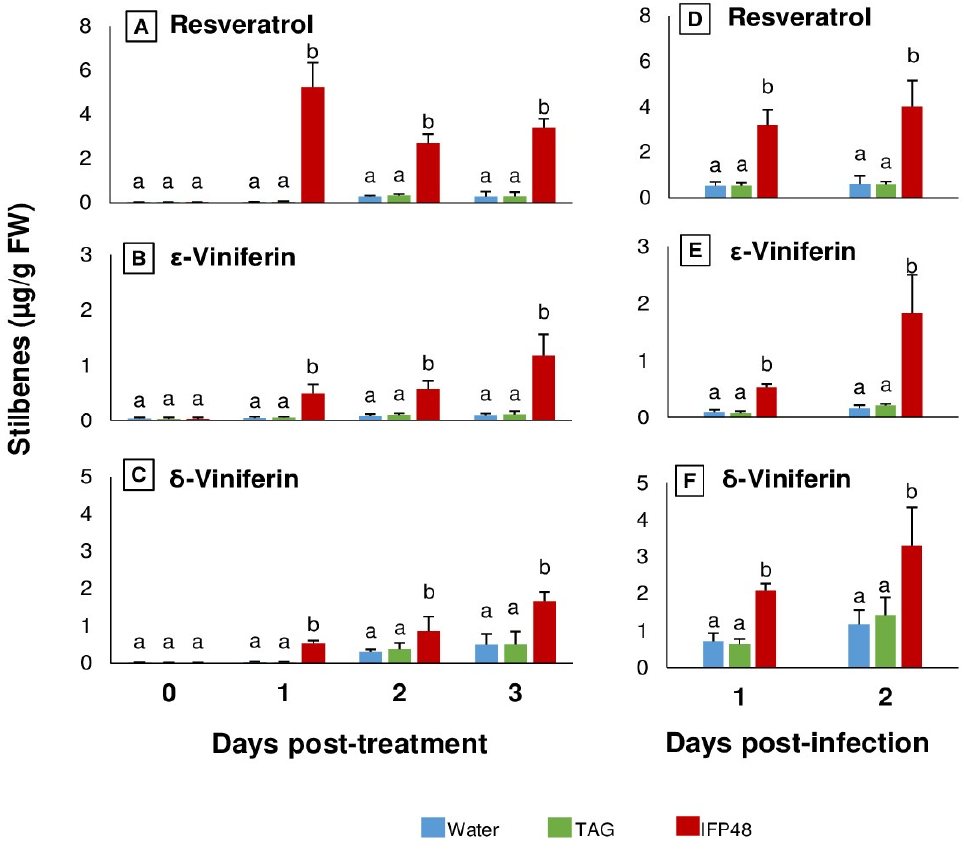
Figure 6. Effects of IFP48 and D-tagatose on resveratrol, ε -viniferin, and δ -viniferin content. Grapevine plantlets were treated with water, 5 g/L D-tagatose-based formulated product (IFP48), or 5 g/L pure D-tagatose (TAG) and leaf samples were collected before ( A – C ) and after Plasmopara viticola inoculation ( D – F ). Data are means ± SD from three independent experiments, each consisted of 18 leaves from 6 in vitro plantlets. Different letters indicate significant differences according to the one-way ANOVA and Tukey’s test ( p ≤ 0.05).